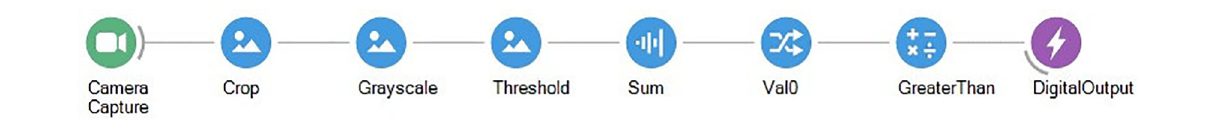
Arduino between +5 V and 0 V, which can be used to turn lights or lasers on or off, trigger reward, or open valves.